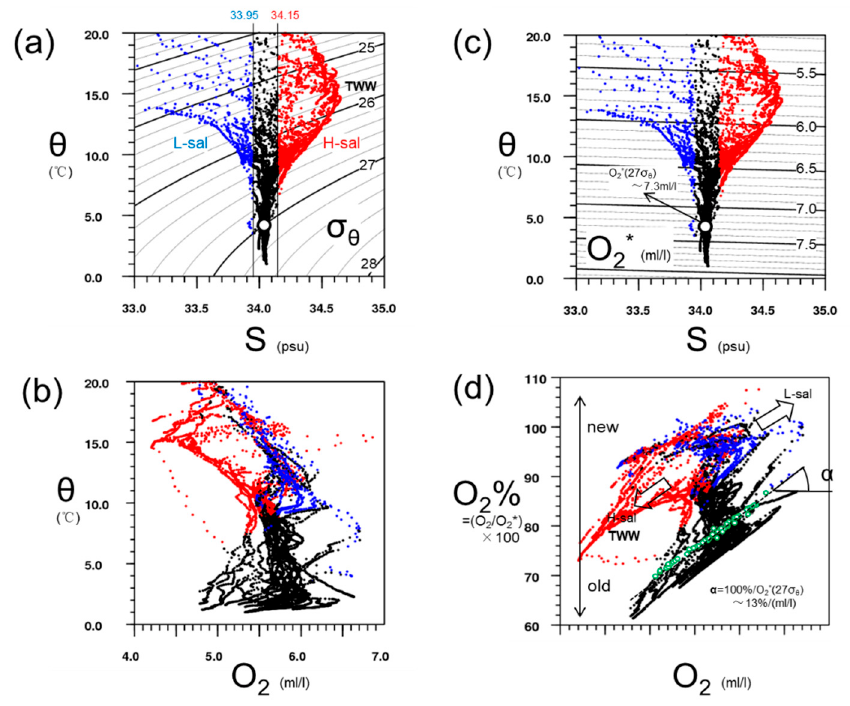
Figure 6. Relationships of ( a , c ) θ -S, ( b ) O 2 - θ and ( d ) O 2 -O 2 %. Slashes in Figure 6a,c are potential density σ θ and O 2 %, respectively.